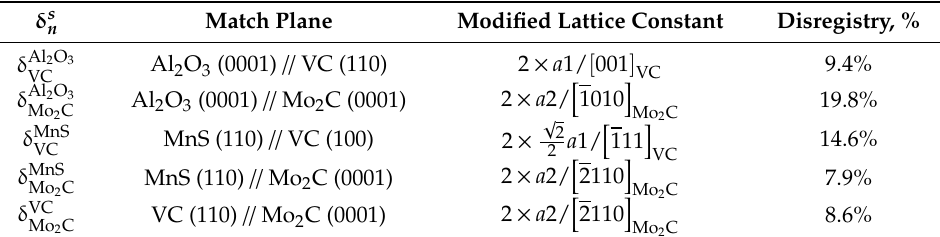
Table 3. Disregistry between the studied phases.